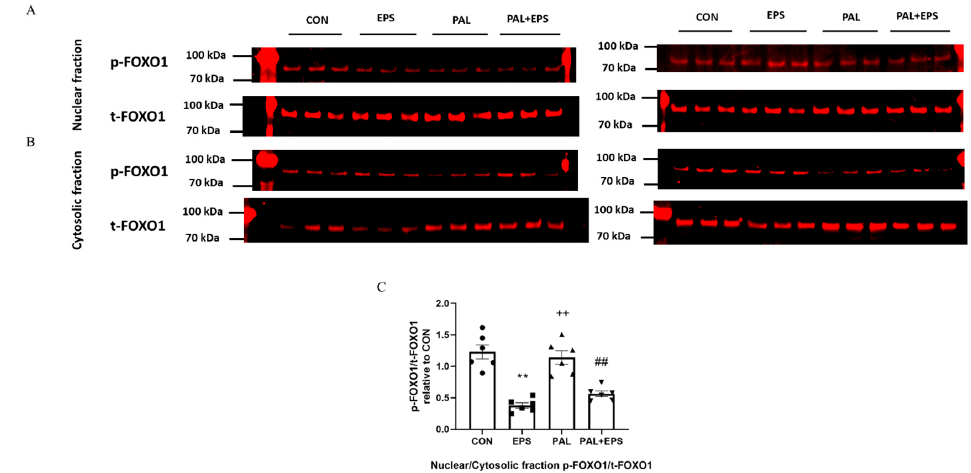
Figure 7. p - and t-FOXO1 protein expression in nuclear ( A ) and cytosolic ( B ) cell fractions and their p -FOXO1/t-FOXO1 ratios normalised to that of nuclear to cytoplasmic factor ( C ) in C2C12 myotubes after exposure to either standard growth media (CON), 16 h of electrical pulse stimulation (EPS; 11.5 V, 1 Hz, 2 ms), 300 μ M palmitate (PAL) or the combination of both interventions (PAL + EPS). Significantly different from control (CON; ** p < 0.01). Significantly different from palmitate (PAL; ## p < 0.01). Significantly different from EPS ( ++ p < 0.01). Data represent mean ± SEM of 6 individual